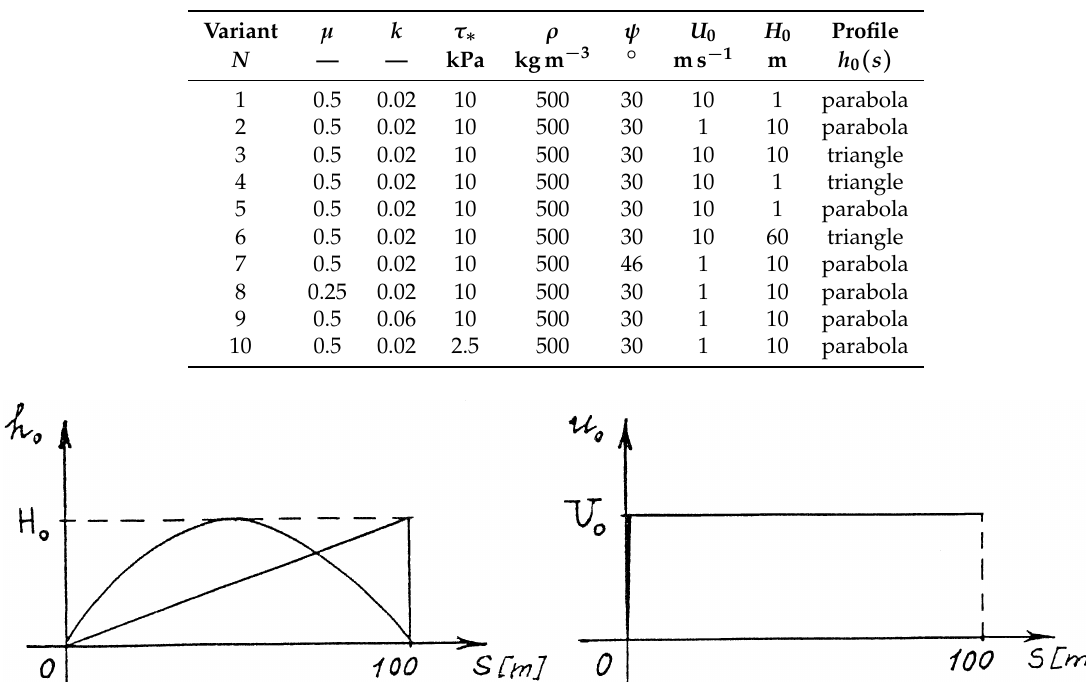
Table 1. The set of numerical values of the problem parameters for tested variants ([1], Note 8).